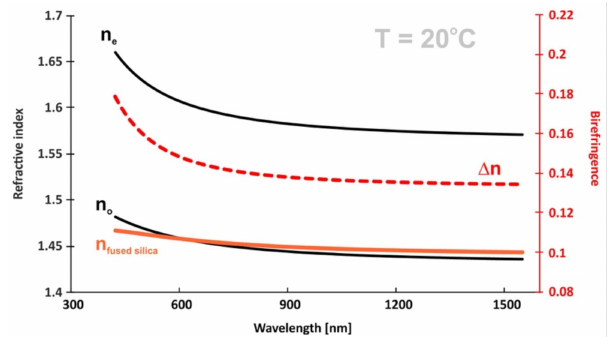
Figure 16. Dispersion of refractive indices (black) and birefringence (red) for multicomponent nematic mixture and refractive index of fused silica (brown) at 20 ◦